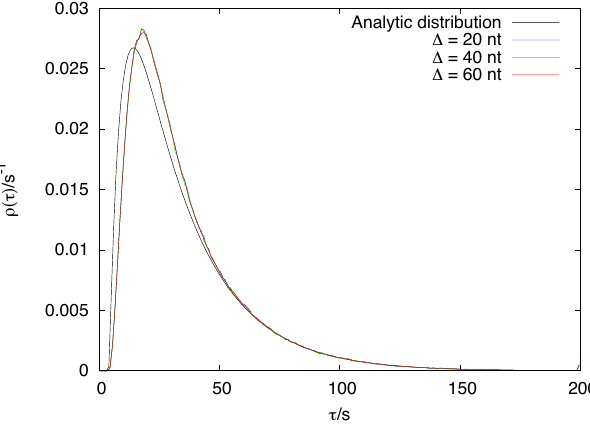
Fig. 6. Analytic distribution of transcription times (replotted from figure 3), and simulated distributions for three different values of ∆ . Each simulated distribution was obtained from stochastic simulations continued until 10 6 RNAs had been synthesized.